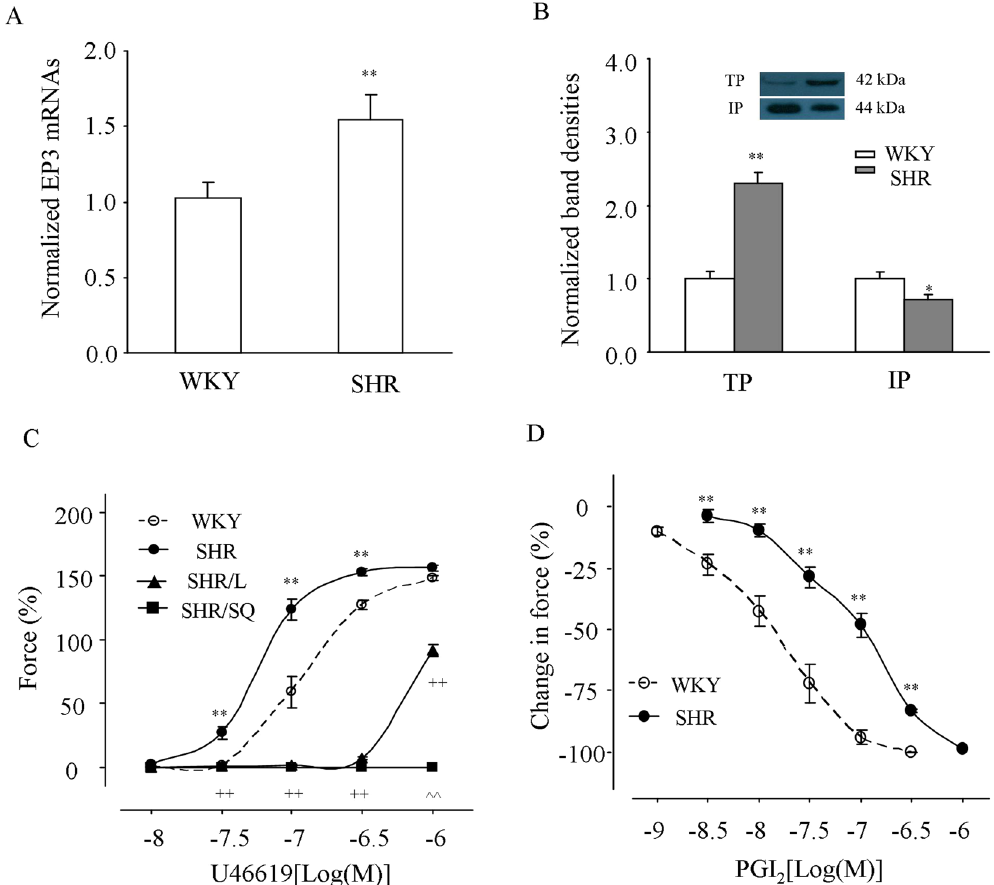
Figure 3. Expressions and/or functions of EP3, TP and IP. ( A ) β -actin normalized EP3 mRNA level detected by real-time PCR in WKY and SHR vessels. N = 6 for each. ( B ) Representative Western blots of TP and IP (left lane: WKY; right lane: SHR) and summary of results (from 5 replicates) showing the band density of TP or IP normalized by that β -actin in WKY and SHR mesenteric resistance arteries. Full length representative Western blots of TP and IP bands and that of β -actin were presented in the supplementary file. In ( A ) and ( B ), the normalized EP3 mRNA level, TP and IP band densities were expressed relative to the average of WKY vessels (which was assumed a value of 1.0). * P < 0.05 and ** P < 0.01 vs. the value in WKY. ( C ) Contractions evoked by the TP agonist U46619 in L-NAME-treated WKY and SHR vessels and that of SHR vessels obtained with TP antagonist SQ29548 (10 μ M; SHR/SQ) or the EP3 antagonist L798106 (1 μ M; SHR/L). ( D ) PGI 2 -evoked relaxation in L-NAME-treated WKY and SHR vessels precontracted with PE (3 μ M) after both EP3 and TP were antagonized (with L798106 and SQ29548). In ( C) and ( D ), n = 5 for each; ** P < 0.01 vs. WKY; ++ P < 0.01 vs. SHR; ^^ P < 0.01 vs.